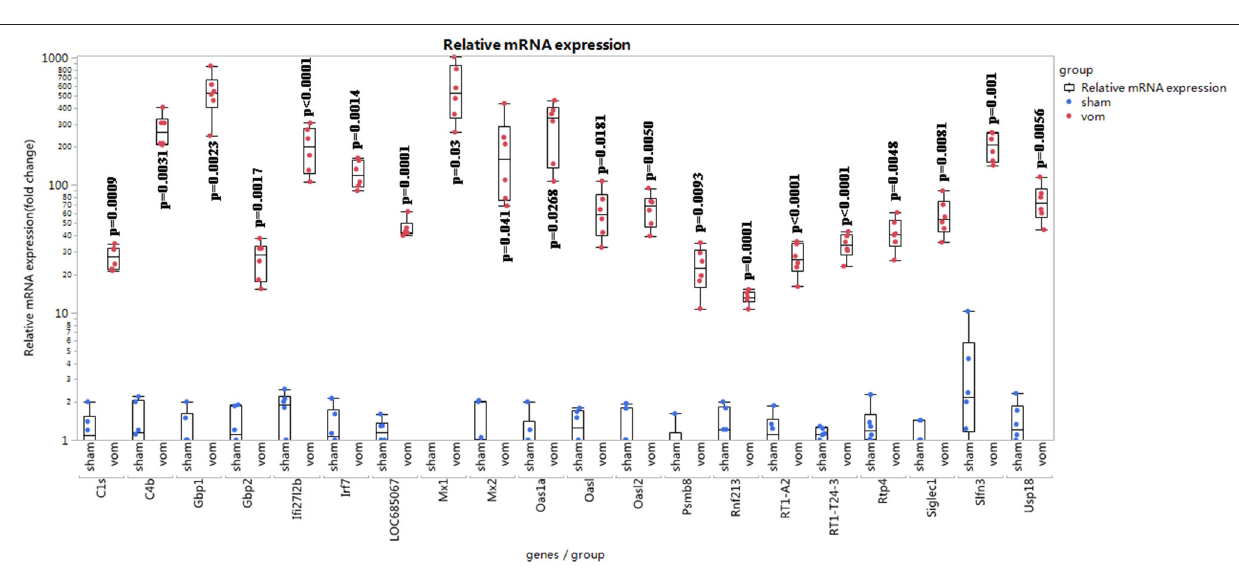
In the adulthood, VO causes fibrosis, hypertrophy, and angiogenesis (9, 10); additionally, in the pre-pubetal stage, VO interrupts cardiomyocyte maturation and reactive cell cycle (17, 18). Current data show that at the neonatal stage,